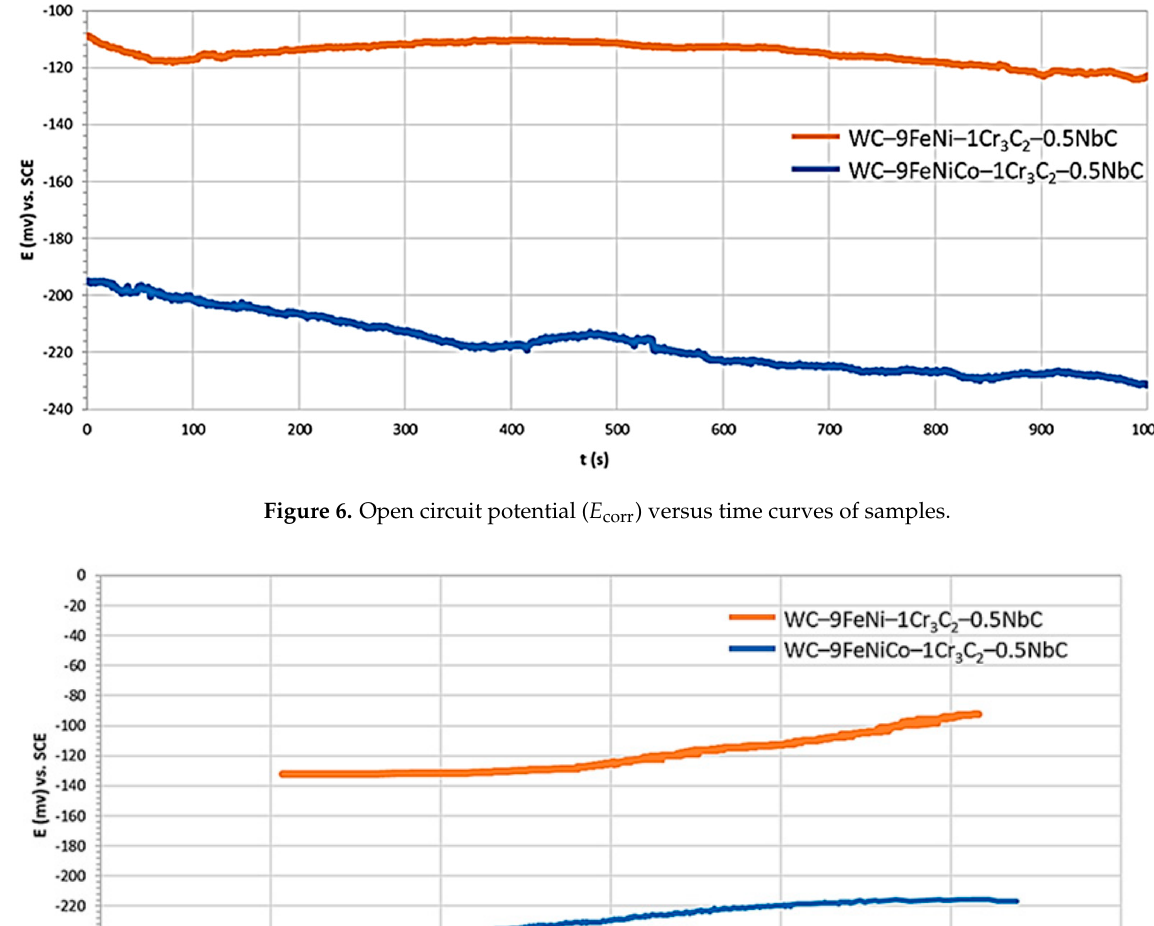
Figure 7. Linear polarization curves of samples.